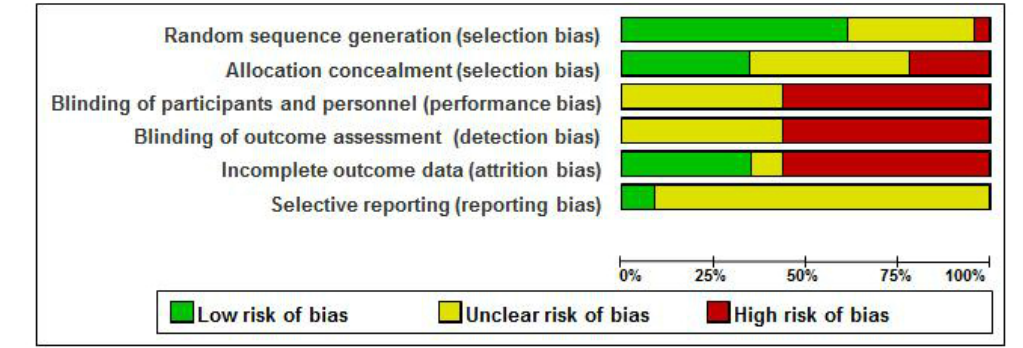
Figure 2. Risk of bias graph.